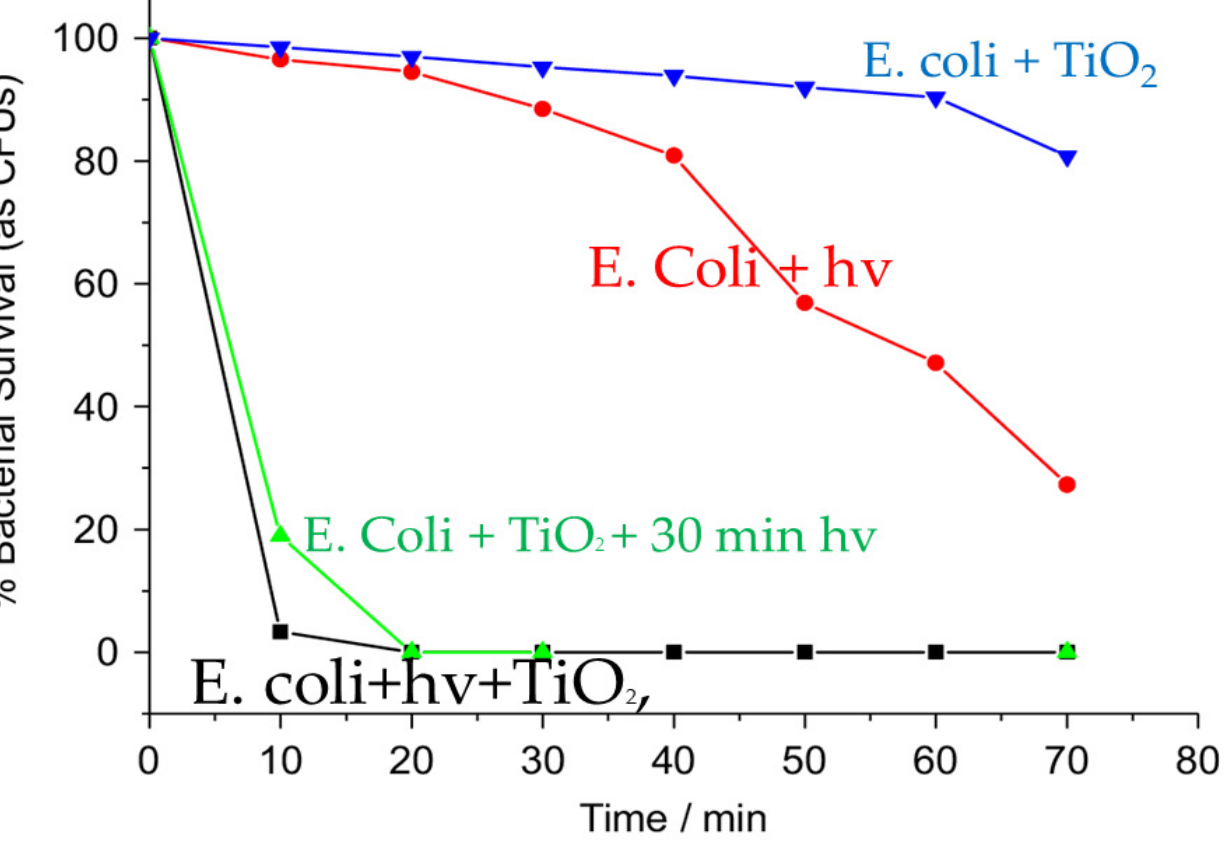
Figure 8. E. Coli cell survival in the presence of TiO 2 nanocontainers for E. coli + TiO 2 , E. coli + hv, E. coli + TiO 2 + 30 min h ν and E. coli + hv + TiO 2